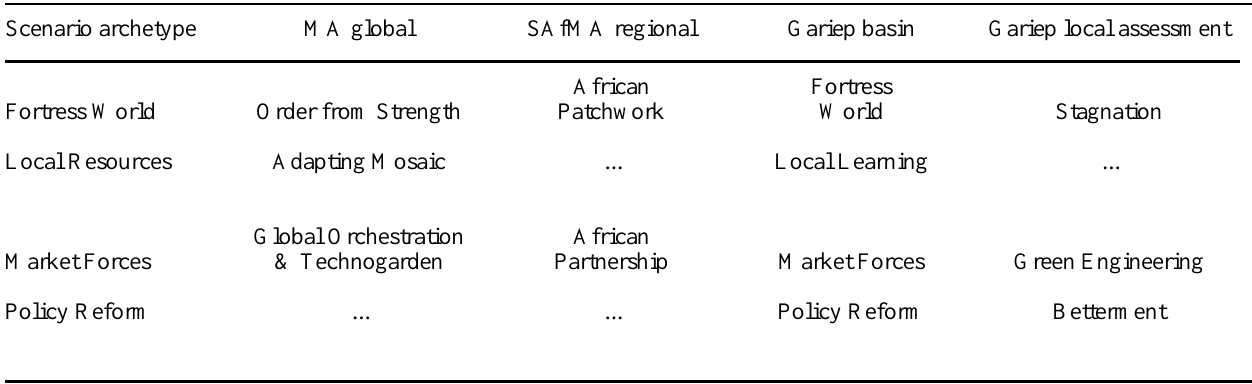
Table 1 . Classification of the Millennium Ecosystem Assessment (MA) global scenarios, the South African Millennium Ecosystem Assessment (SAfMA) regional scenarios, the Gariep basin scenarios, and the Gariep local assessment scenarios into four scenario archetypes (Biggs et al.